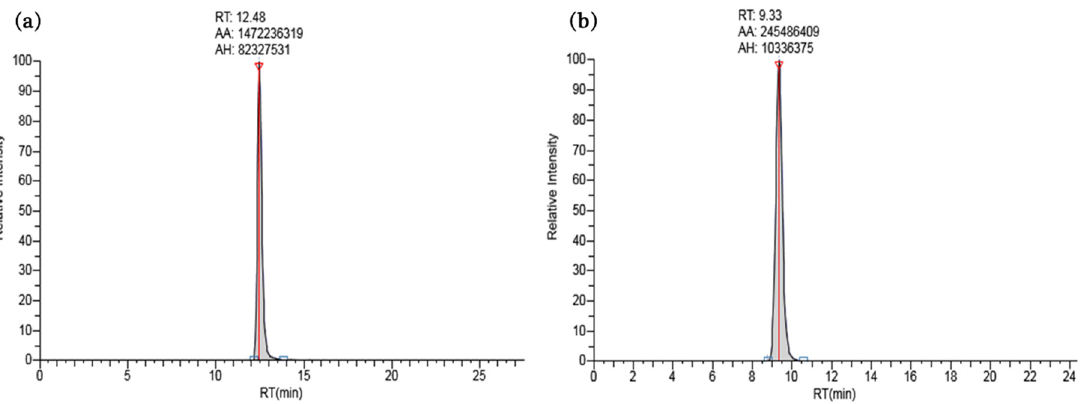
Figure 2. UHPLC traces of standard solutions (750 ng · L − 1 ) of ( a ) altrenogest, and ( b ) ampicillin. These chromatograms are representative of the 41 target pesticides and veterinary pharmaceuticals; traces for the remaining 39 chemicals are available in the Supplementary Materials (Figures S1–S2).